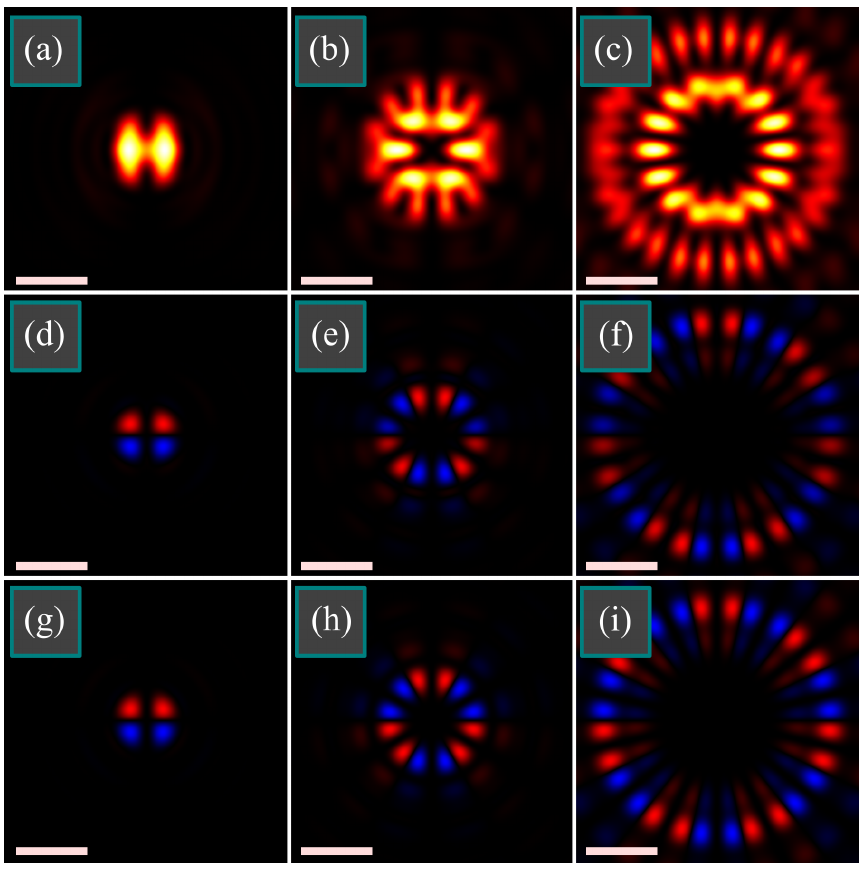
Figure 4. Distributions of intensity | E x | 2 + | E y | 2 + | E z | 2 ( a – c ) and of longitudinal SAM density 2Im{ E x * E y } ( d – i ) of tightly focused light field with double-index polarization singularity of the orders ( m , n ) = (1, 2) ( a , d , g ), ( m , n ) = (3, 6) ( b , e , h ), ( m , n ) = (7, 14) ( c , f , i ) at the following parameters: wavelength λ = 532 nm, focal length of the lens f = 10 µ m, numerical aperture sin α = 0.95, amplitude apodization function is homogeneous, i.e., A ( θ ) ≡ 1. SAM distributions were computed directly by Equation (8) ( d – f ) and by an approximate Equation (20) ( g – i ). All the figures have the size 4 × 4 µ m 2 (scale mark shows 1 µ m). Light and dark colors in the intensity distribution mean maximum and zero. Red and blue colors ( d – i ) mean, respectively, positive and negative